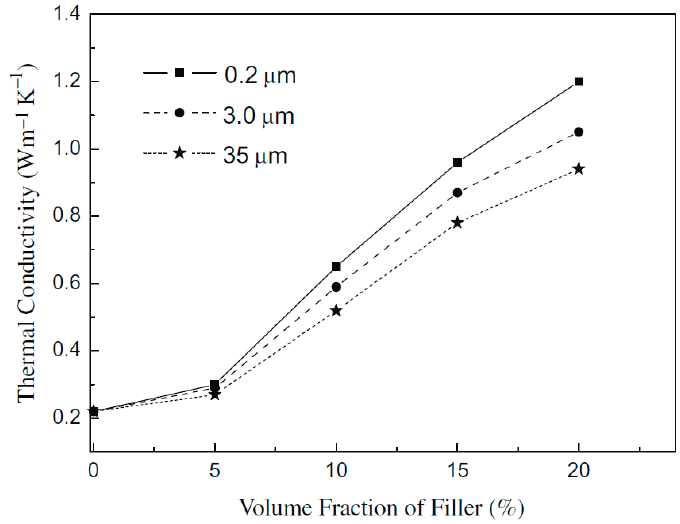
Figure 6. Impacts of filler diameter and volume fraction on thermal conductivity of composites. Reprinted with permission of Elsevier [95].